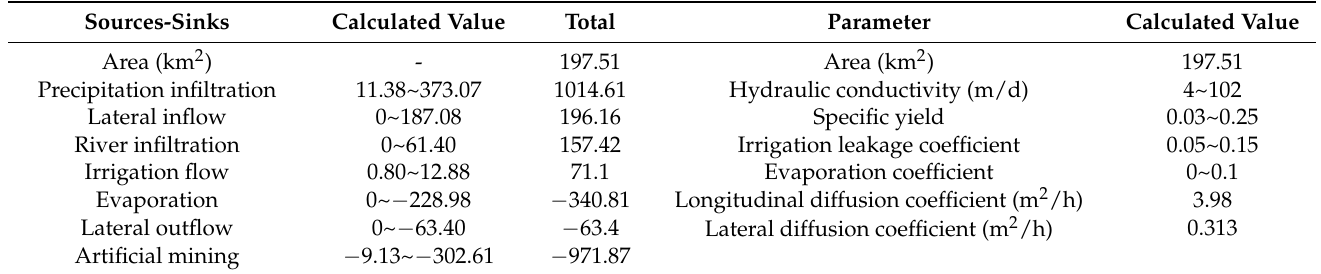
Table 4. Calculated value of sources-sinks and the final hydrogeological parameters.